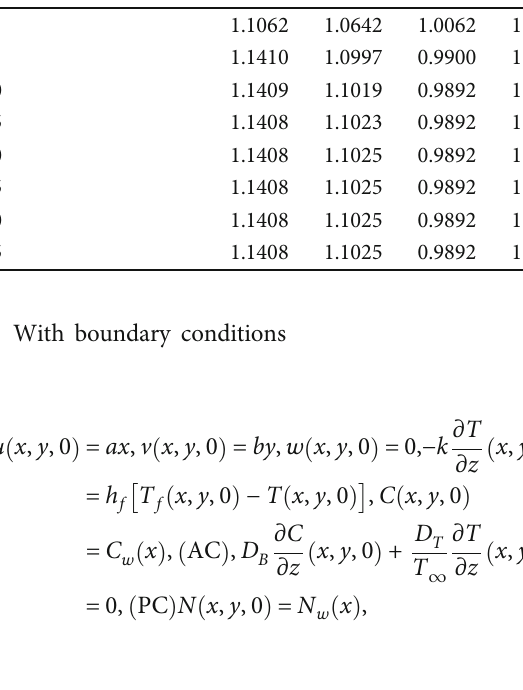
Table 1: Order of approximation for − f Order of